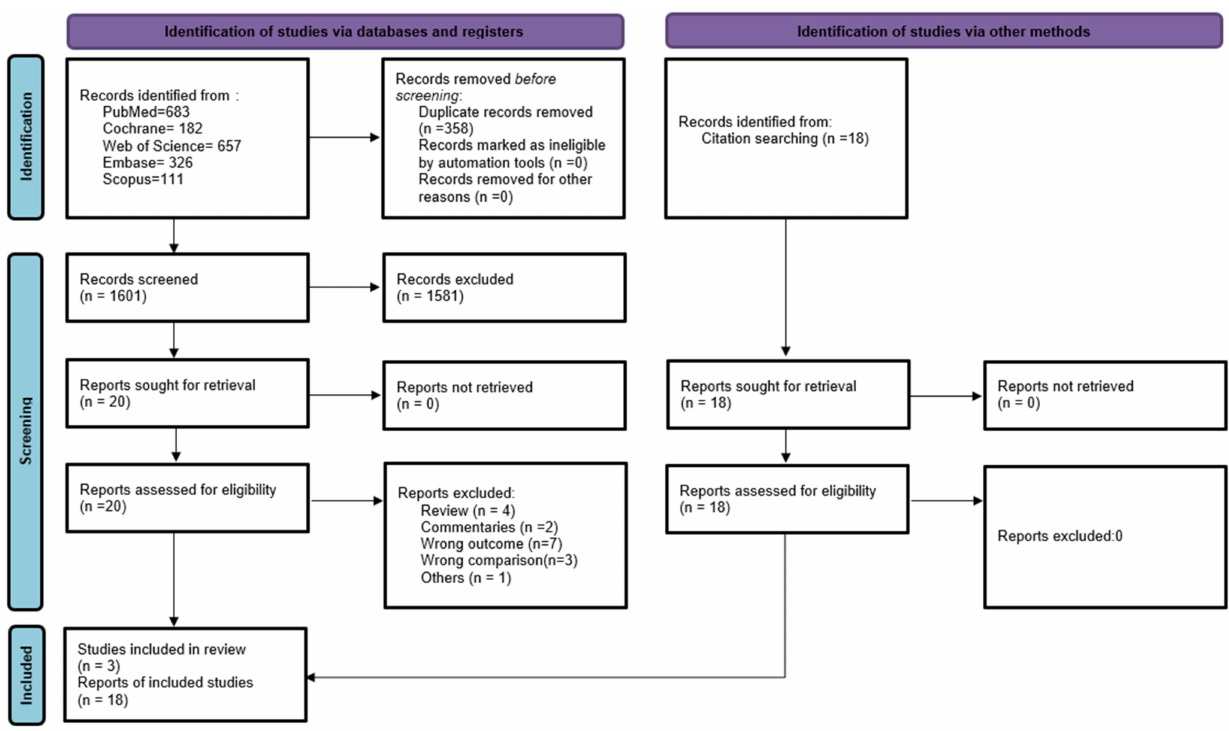
Figure 1. PRISMA 2020 flow diagram. Diagram of searches performed and the number of articles returned and examined at each